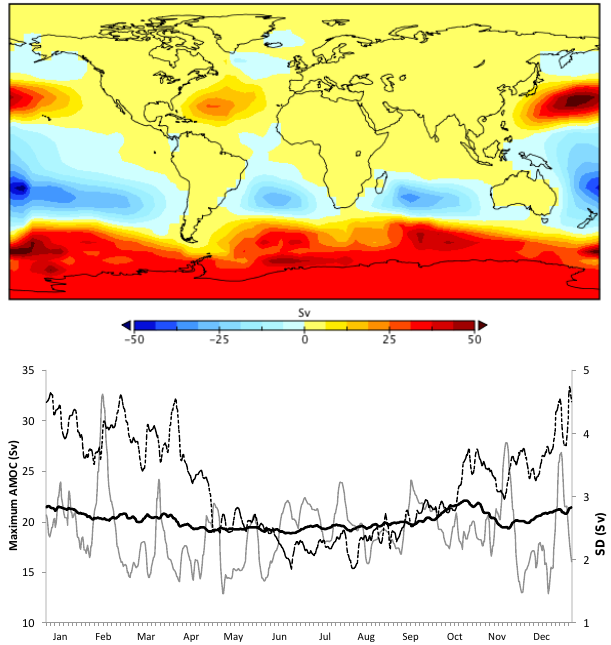
Figure 7. Upper panel: PLASIM–GENIE barotropic stream func- tion. Lower panel: Wind-driven AMOC variability: solid black 100- year mean, dashed black 100-year standard deviation, solid grey ar- bitrary year (year 1 of a 100-year spin-on